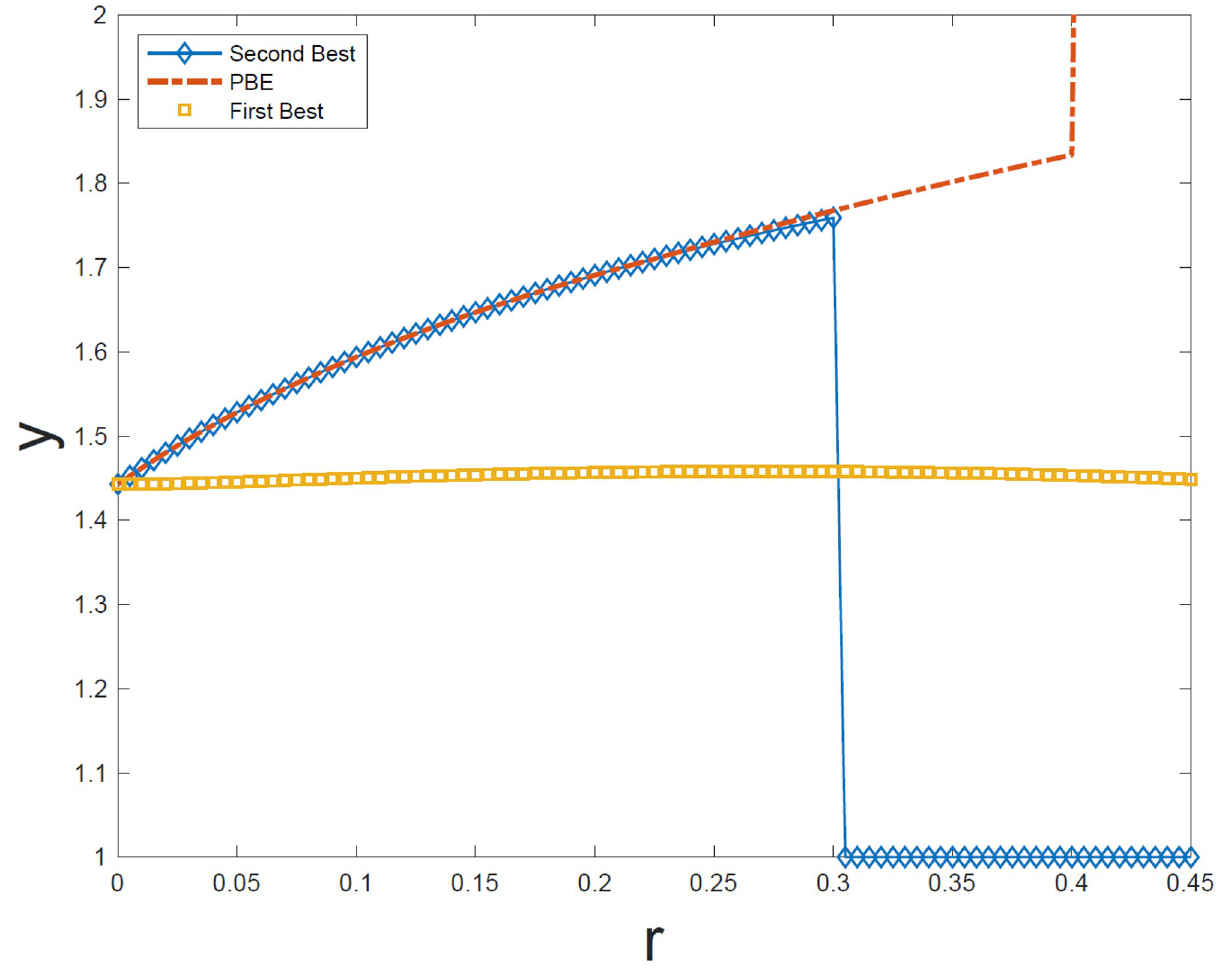
Fig 1. Re-election standards under second best and PBE, and FB with α =